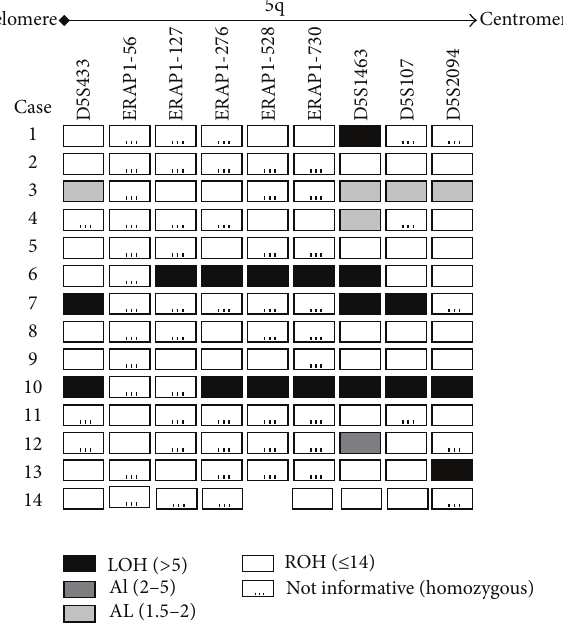
Figure 2: Patterns of microsatellite instability in 14 patients with ERAP1